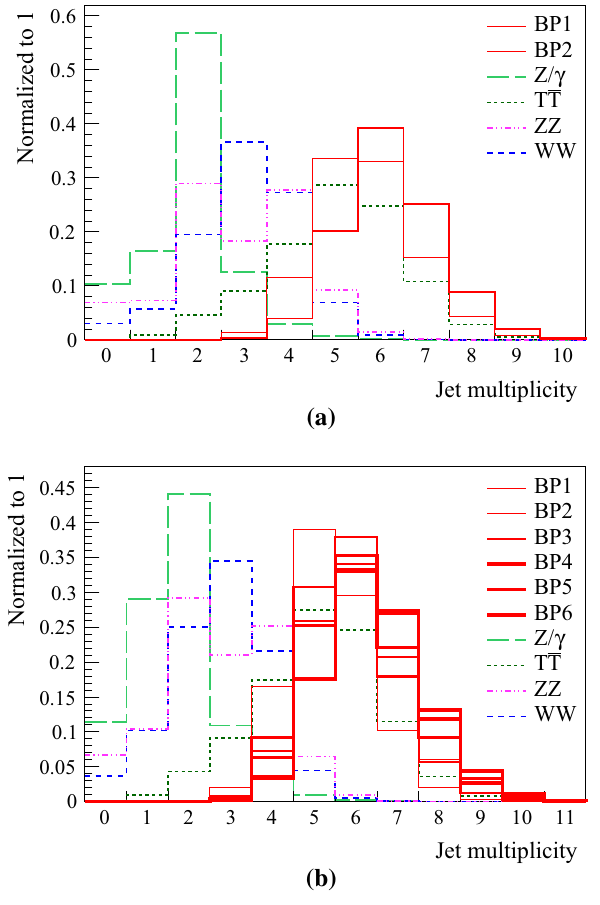
Fig. 3 b -jet multiplicity distributions corresponding to different signal and background processes at the center-of-mass energies of a 500 and b 1000 GeV is computed for the three possible b -jet pairs and the pair which has the minimum (cid:11) R bb value is considered as